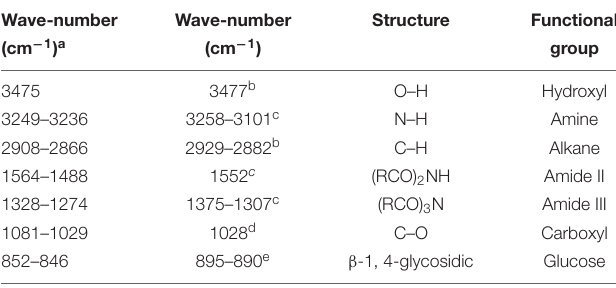
TABLE 4 | Identification of functional groups and bonds based on the peak FTIR on horseshoe crab shell and other crab shells.